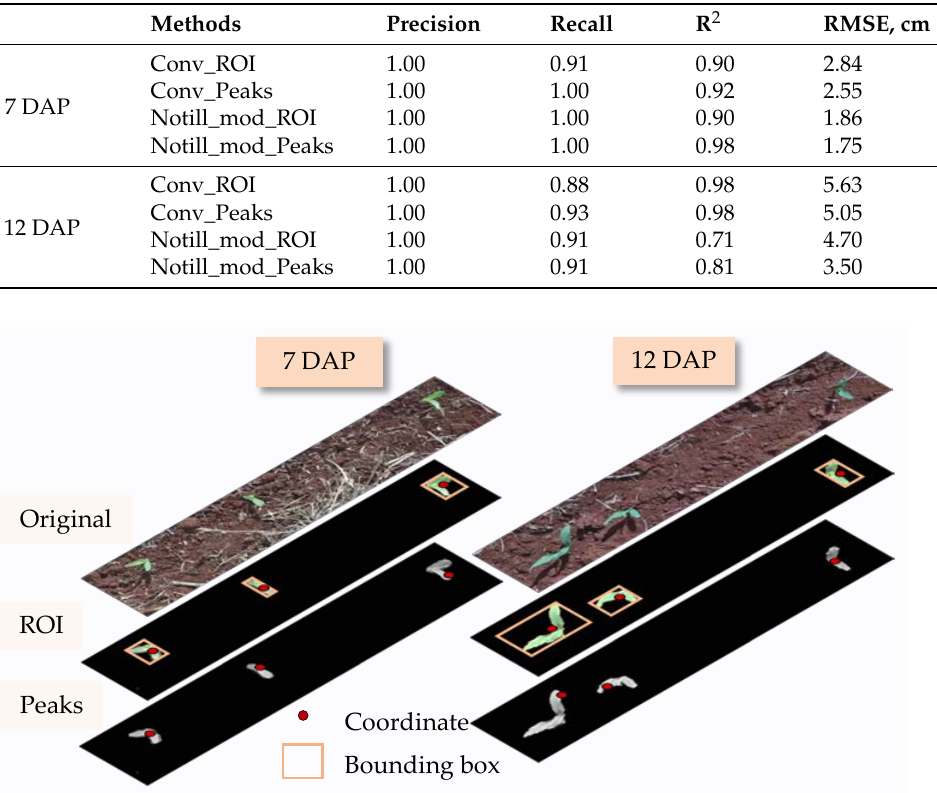
Figure 4. Overall aspect from both methods (no-till adapted).